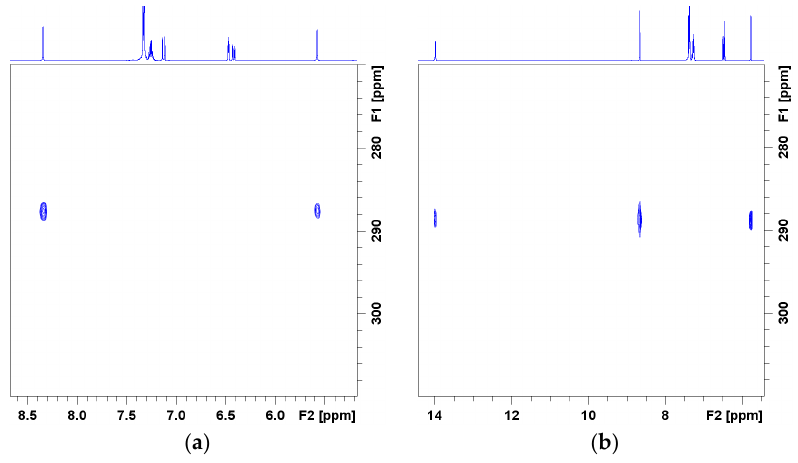
Figure D12. 1 H– 15 N HMBC NMR spectra of mvanadpm in ( a ) CDCl 3 and ( b ) DMSO-d 6 .